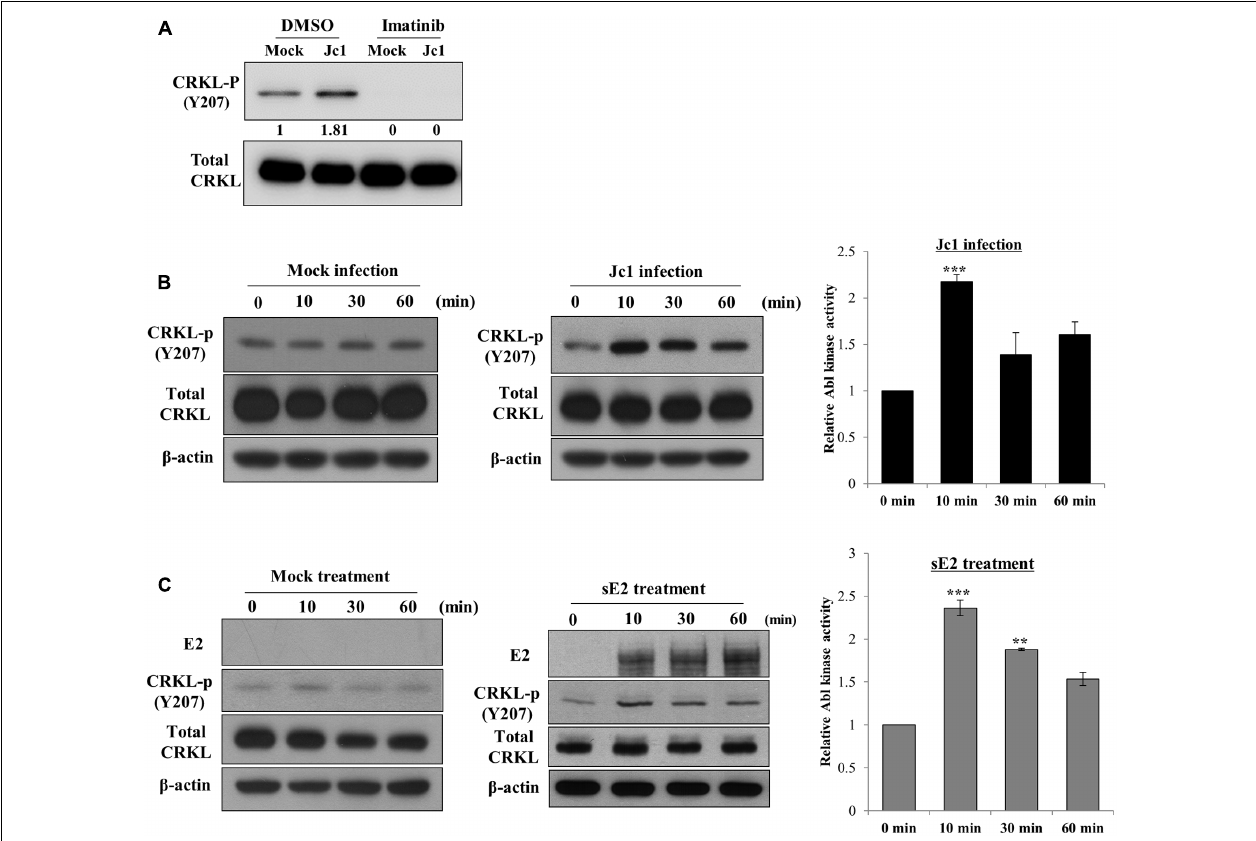
FIGURE 4 | Hepatitis C virus infection activates Abl kinase. (A) Huh7.5 cells were serum-starved for 16 h and then treated with either DMSO (vehicle) or 10 µ M of imatinib for 2 h. Cells were either mock-infected or infected with Jc1 using an MOI of 5. At 10 min post-infection, total cell lysates were immunoblotted with the indicated antibodies. (B) Huh7.5 cells were serum-starved for 16 h and then either mock-infected (left panel) or infected with Jc1 (middle panel). At the indicated time points, total cell lysates were immunoblotted. (Right panel) Abl kinase activities were determined by measuring band intensities of CRKL-p/total CRKL using ImageJ and shown as relative fold from the mock control. (C) Huh7.5 cells were serum-starved for 16 h and then either mock-treated (left panel) or treated with 10 µ g sE2 derived from H77 (middle panel). Total cell lysates harvested at each time points were immunoblotted with the indicated antibodies. (Right panel) Abl kinase activities were determined by measuring band intensities of CRKL-p/total CRKL using ImageJ and shown as relative fold from the mock control. sE2, soluble HCV E2 protein. The asterisks indicate significant differences ( ∗∗ P < 0.01; ∗∗∗ P <